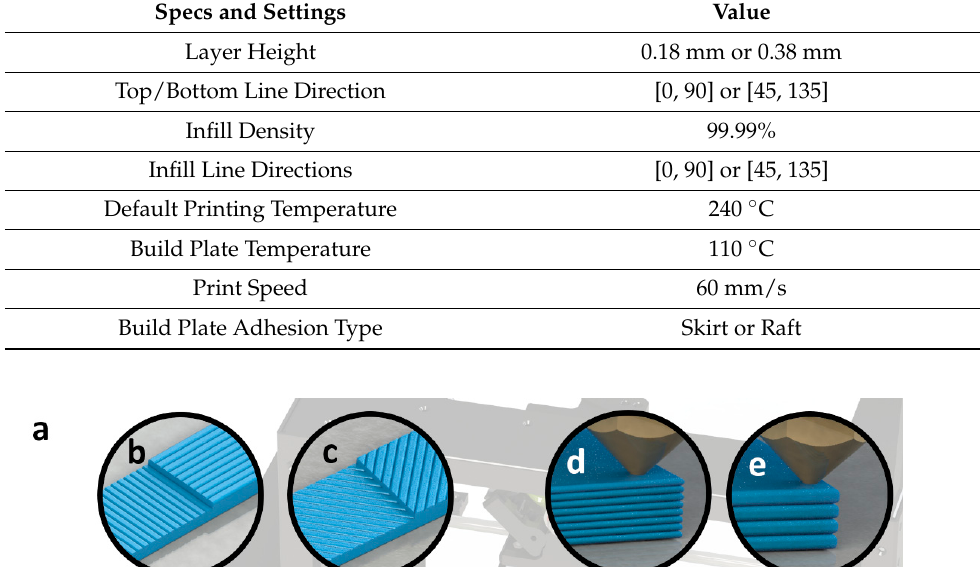
Figure 2. Specimens with layer thicknesses of 0.18 mm and 0.38 mm, skirt and raft adhe- Table 1. Settings and parameters of 3D printer used to produce the specimens. Table 1. Settings and parameters of 3D printer used to produce the specimens.